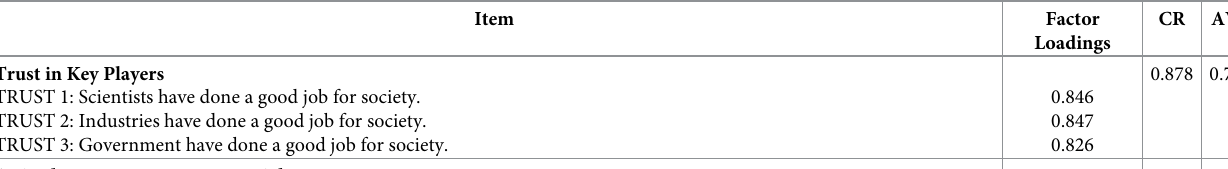
Table 3. Internal Consistency and Convergent